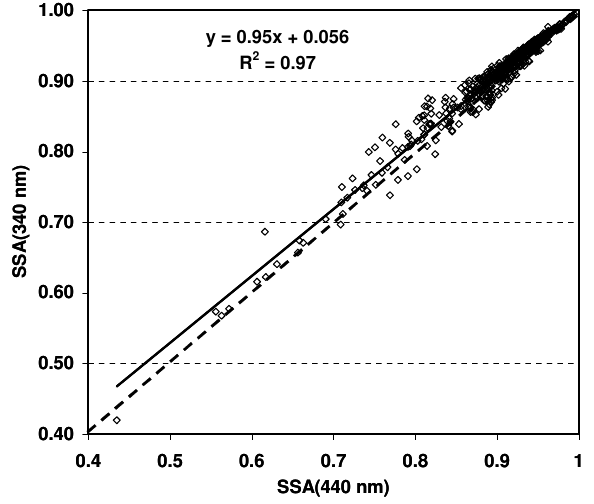
Fig. 6. Correlation and fit of SSA at 340nm and 440nm.